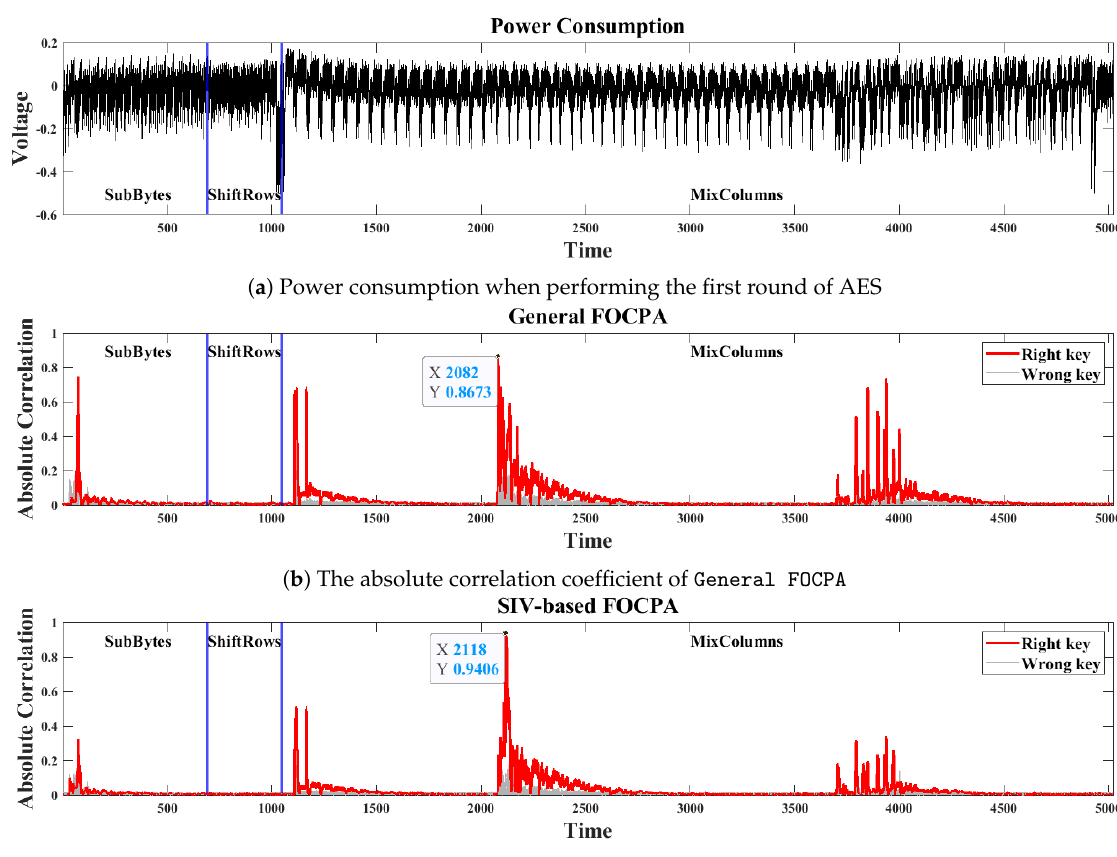
Figure 2. Results of General FOCPA and SIV-based FOCPA (0th